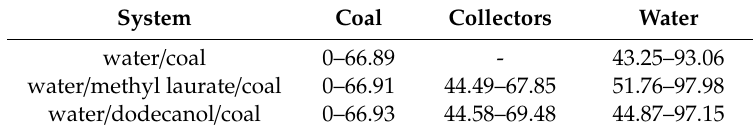
Table 7. The density distribution range of water, collector, and Bulianta coal molecules along Z axis (Å).